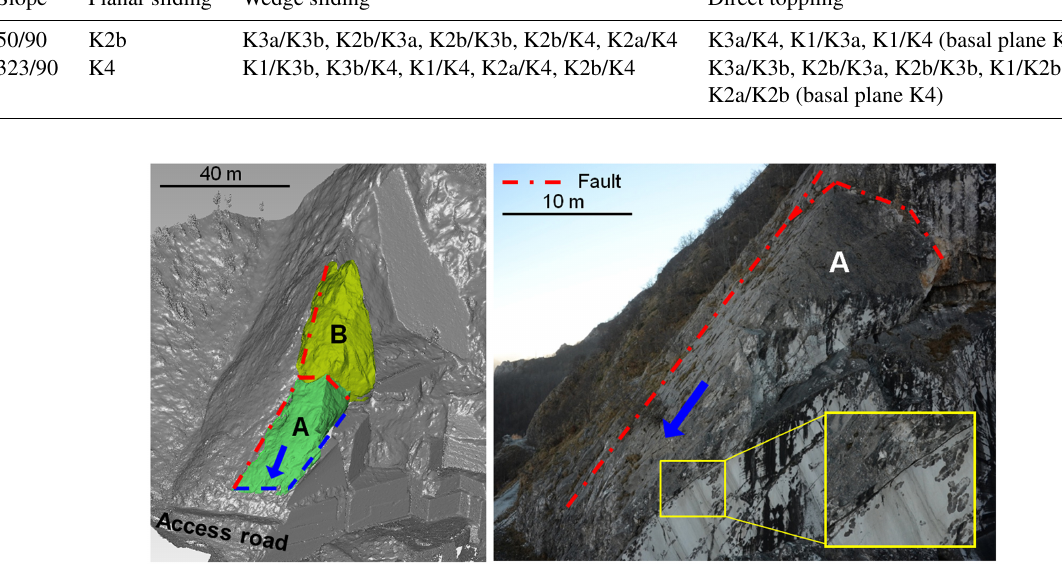
Figure 9. Identification of two large blocks with potential for sliding; inset photo highlights the visible aperture of the basal plane.